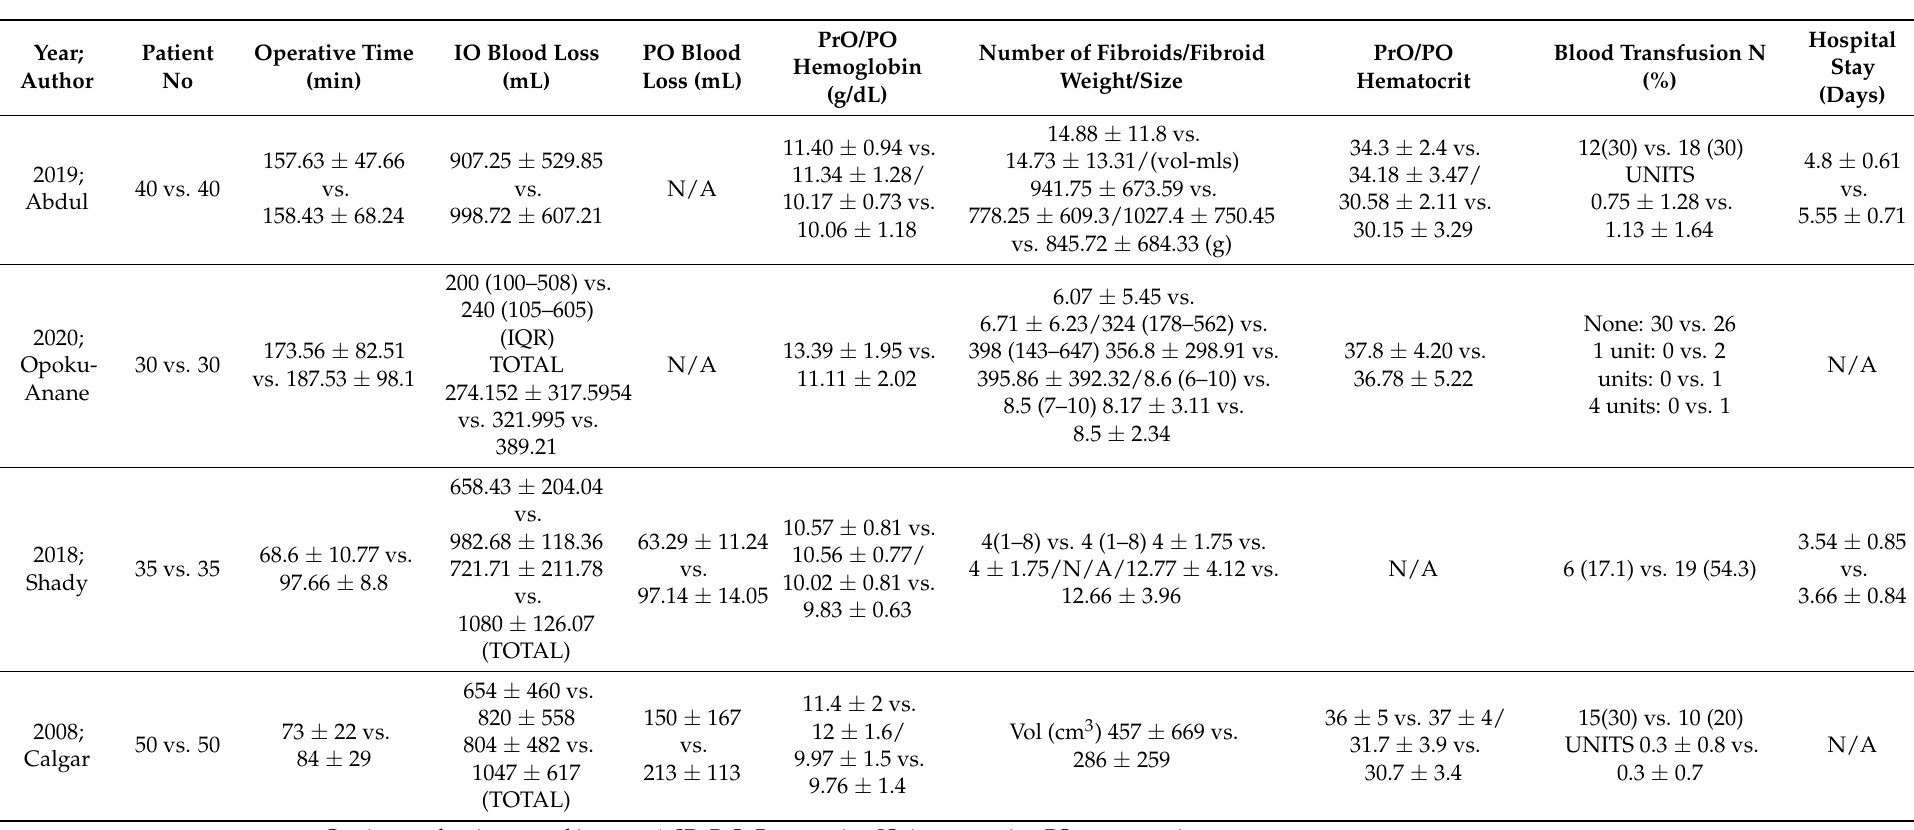
Table 2. Main outcomes of the included